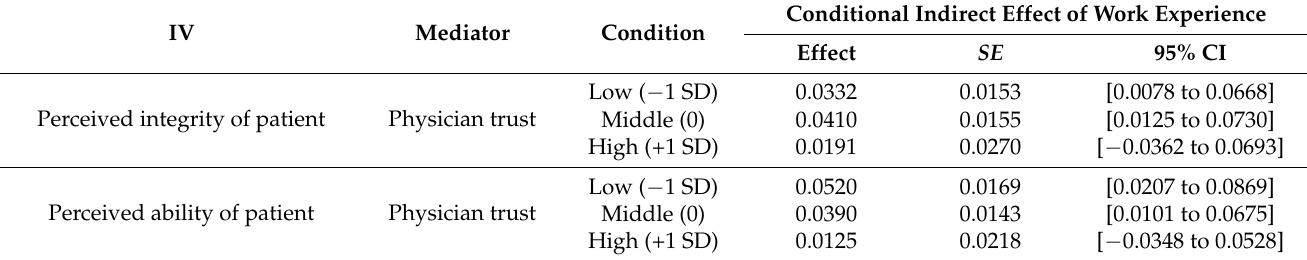
Table 3. Conditional indirect effect of perceived integrity and perceived ability of the patient on communication efficacy through physician trust moderated by work